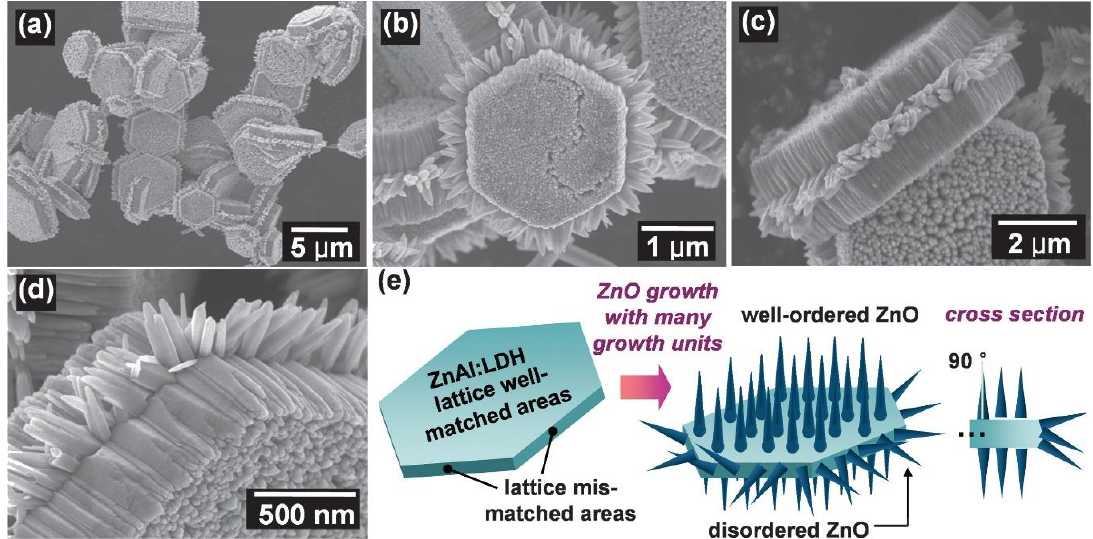
Figure 29. SEM images of sunflower-like ZnO nanorods/ZnAl:LDH heterostructures: ( a ) low magnification; ( b , c ) medium magnification; ( d ) high magnification; ( e ) schematic illustration of the formation of the sunflower-like ZnO nanorods/ZnAl:LDH heterostructures. Republished with permission of © The Royal Society of Chemistry, from [723], Copyright (2009), permission conveyed through Copyright Clearance Center, INC. All rights reserved. In order to re-use permission must be obtained from the rightsholder.